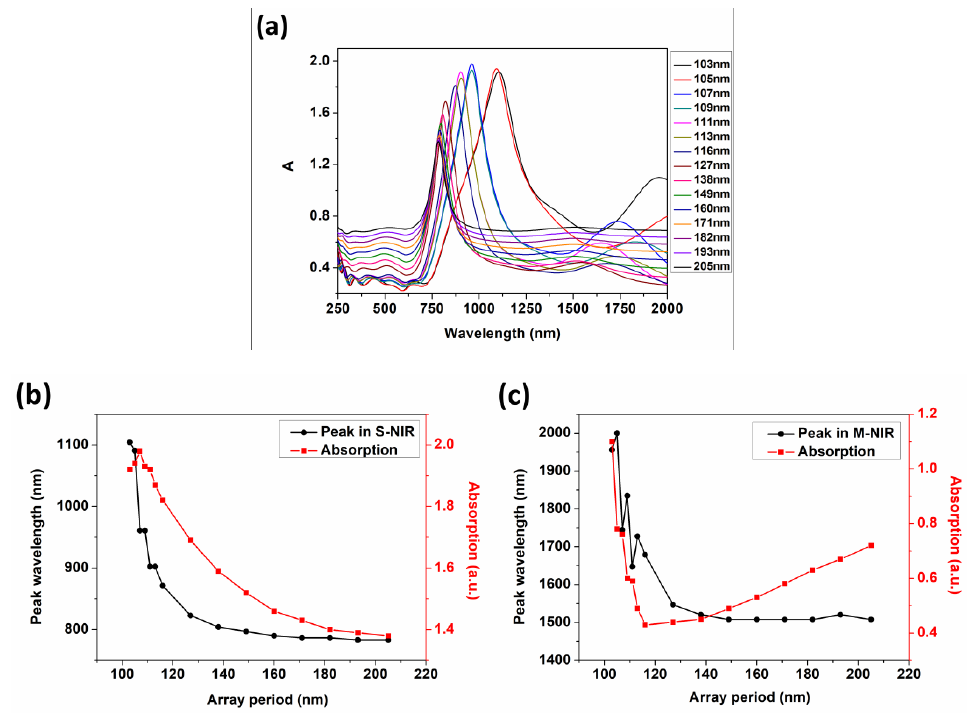
Figure 2. ( a ) The absorption spectra under different periods; ( b ) The scatter diagram of the absorption peak positions and intensities in S-NIR; ( c ) The scatter diagram of the absorption peak positions and intensities in M-NIR.